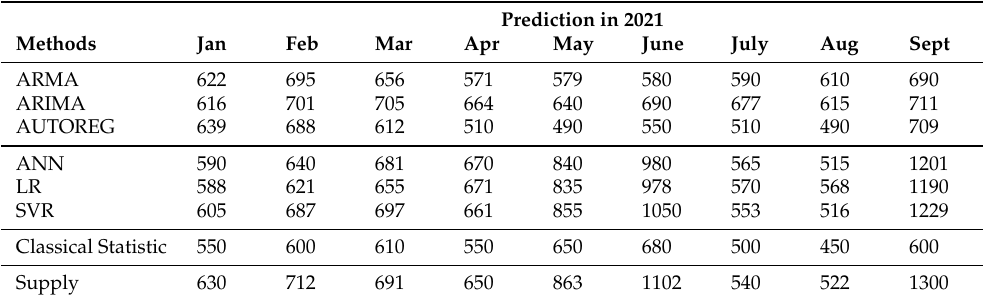
Table 12. Blood supply predictions using the best performing methods (time series and machine learning models).